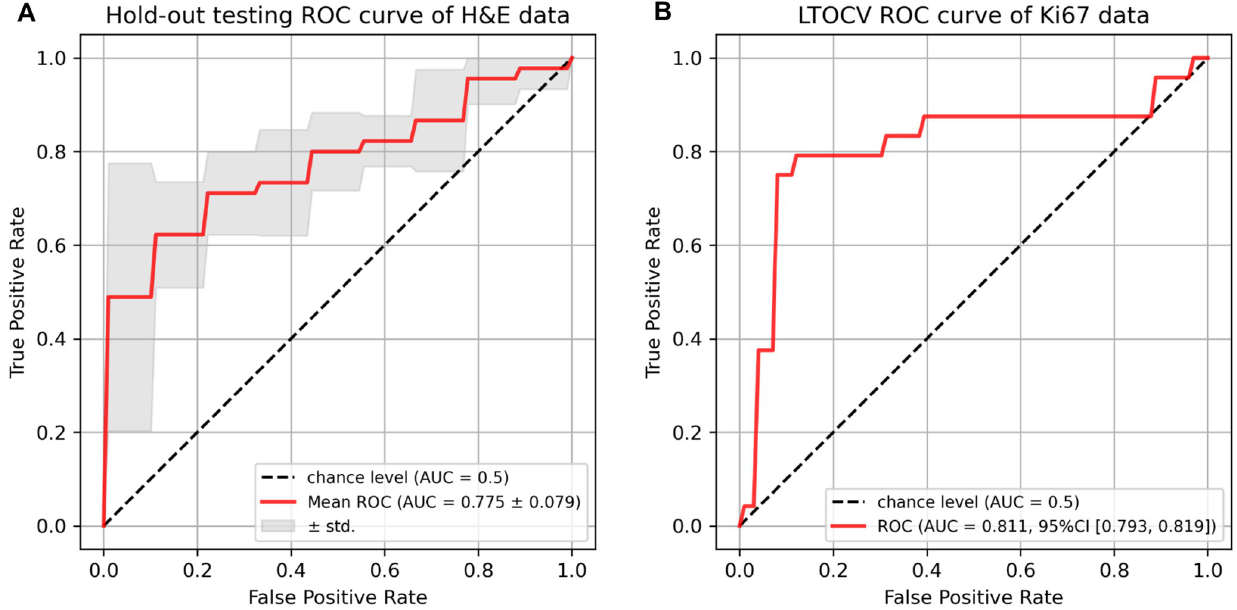
Fig 8. Receiver operating characteristic (ROC) curves of BCR-Net on H&E and Ki67-stained slides. (a) Hold-out testing ROC curves on H&E-stained slides. The red curve indicates the mean curve based on the five folds’ testing results and the gray shadow indicates the standard deviation. (b) LTOCV ROC curves on the Ki67-stained slides. The red curve indicates the mean curve based on the validation results of the LTOCV.